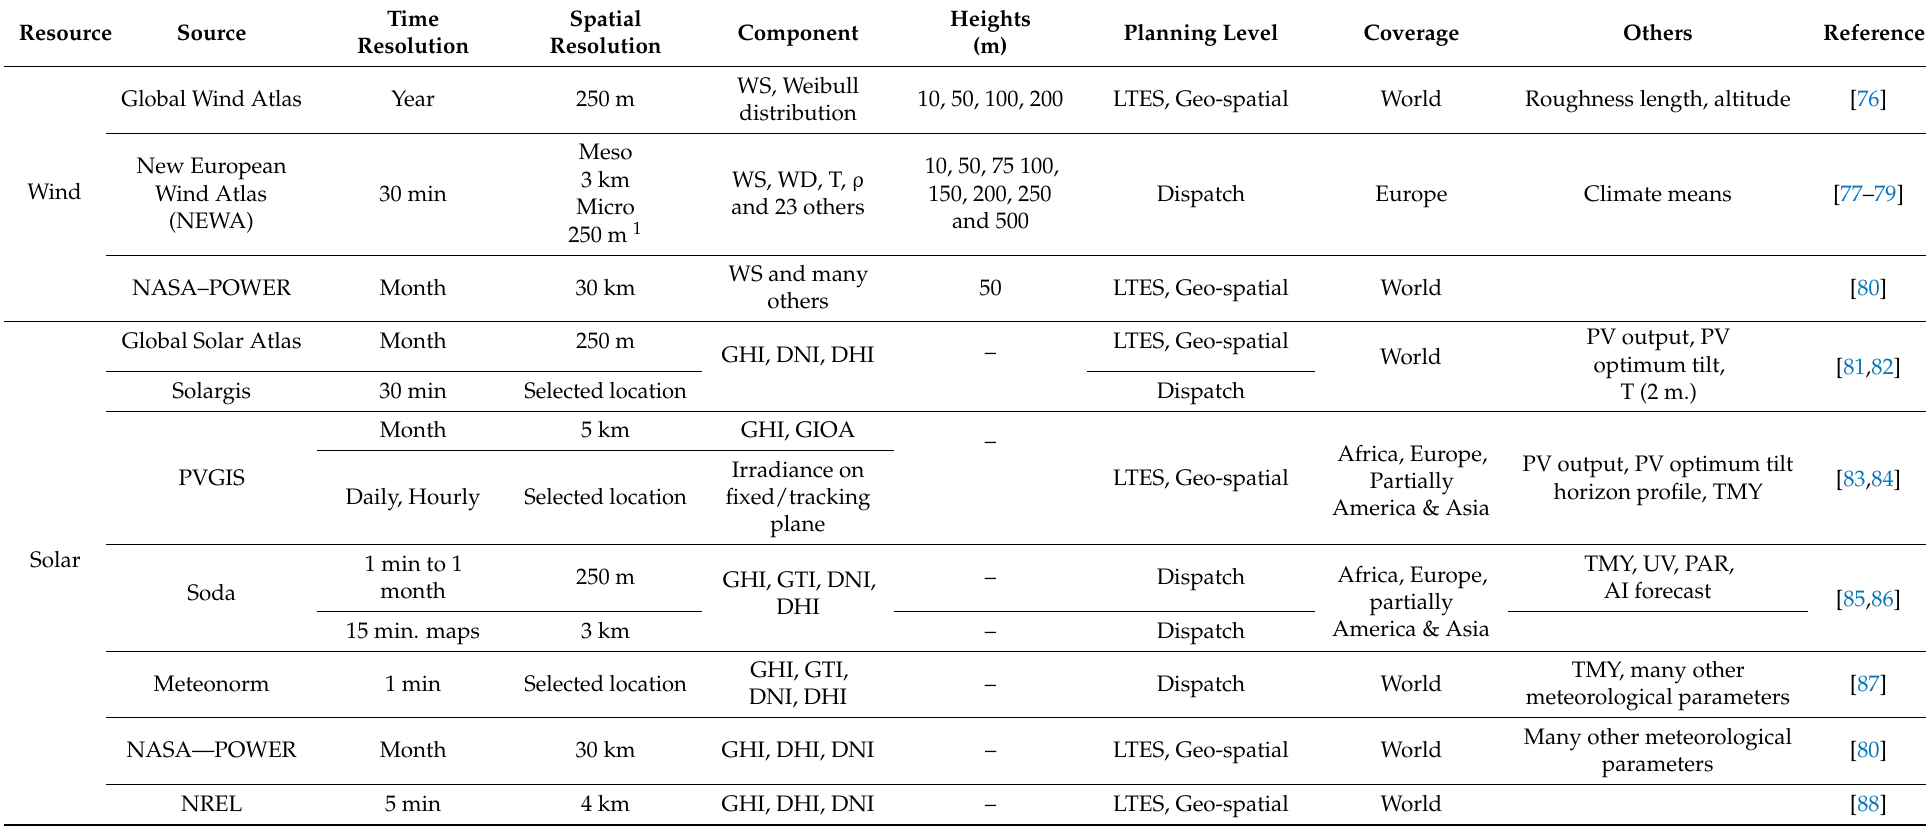
Table 3. Main characteristics of the existing sources for wind and solar resources